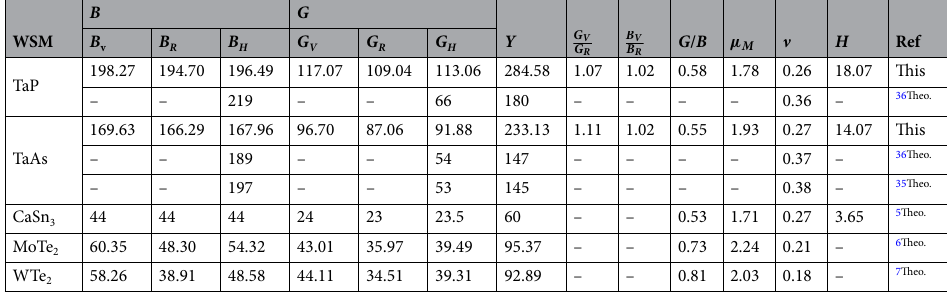
Table 3. The calculated isotropic bulk modulus B (GPa), shear modulus G (GPa), Young’s modulus Y (GPa), Pugh’s indicator G/B , Machinability index μ M , Poisson’s ratio ν and hardness H (GPa) of TaP and TaAs compounds deduced from Voigt-Reuss-Hill (VRH) approximations. Relevant parameters of some other WSMs with different crystal symmetry are also given.